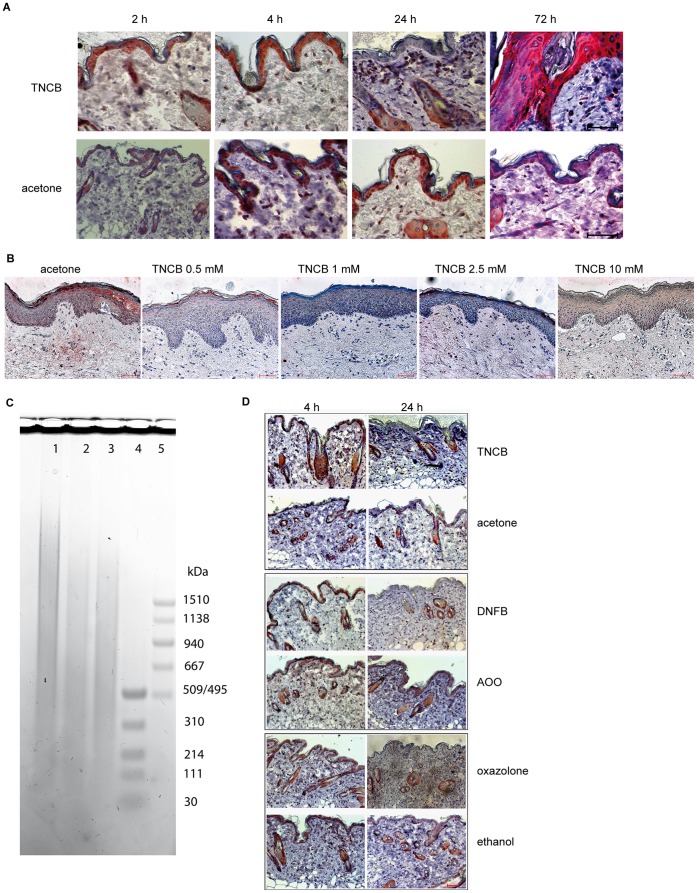
Contact sensitizers induce HA degradation in vivo.
(A) Staining of HA in TNCB or acetone treated murine skin. Biopsy samples from murine abdominal skin were fixed as described and paraffin sections (3 µm) were stained with bHABP with subsequent AEC (3-Amino-9-ethylcarbazole) staining and haematoxylin counterstaining. HA is stained brown/red and cell nuclei in blue. Pictures are representative of three independent experiments with three mice each. Magnification  = 400×, scale bar  = 50 µm. (B) Staining of HA in TNCB treated human skin. Biopsy samples were treated with indicated concentrations of TNCB for 24 h and afterwards treated like the murine samples above. Pictures are representative of samples from three independent donors. Magnification  = 200×, scale bar  = 50 µm. (C) Abdominal skin was excised either untreated (lane 1), or 4 h (lane 2) or 24 h (lane 3) after application of TNCB (3%). Samples (8 mm diameter) were digested and the molecular weight of HA of the samples was determined by agarose gel electrophoresis. In lane 4 and 5 molecular weight markers (5 µl/lane of HiLadder or LoLadder) were loaded. The picture shows one representative gel out of three. (D) Abdominal mouse skin was treated with sensitizers (TNCB, DNFB or oxazolone) and HA staining was performed 4 or 24 h later. Respective solvent controls (acetone, acetone/olive oil (AOO), ethanol) are shown below. Biopsy samples from murine abdominal skin were fixed as described and paraffin sections (3 µm) were stained with bHABP with subsequent AEC (3-Amino-9-ethylcarbazole) staining and haematoxylin counterstaining. HA is stained brown/red and cell nuclei in blue. Pictures are representative of three independent experiments with three mice each. Magnification  = 200×, scale bar  = 50 µm.